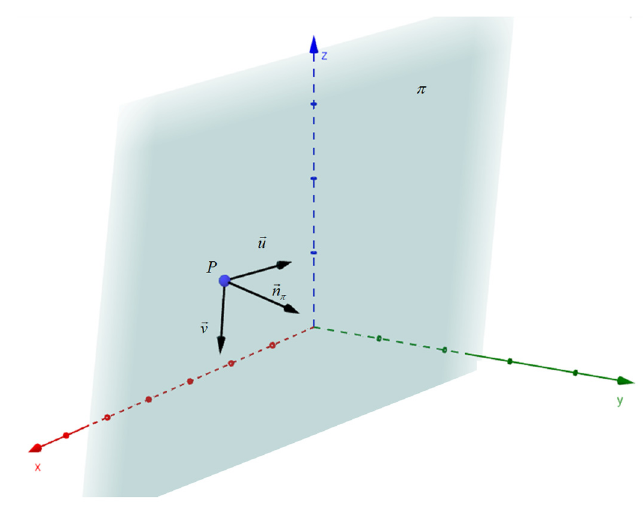
Figure 19. Vectors of the π plane.